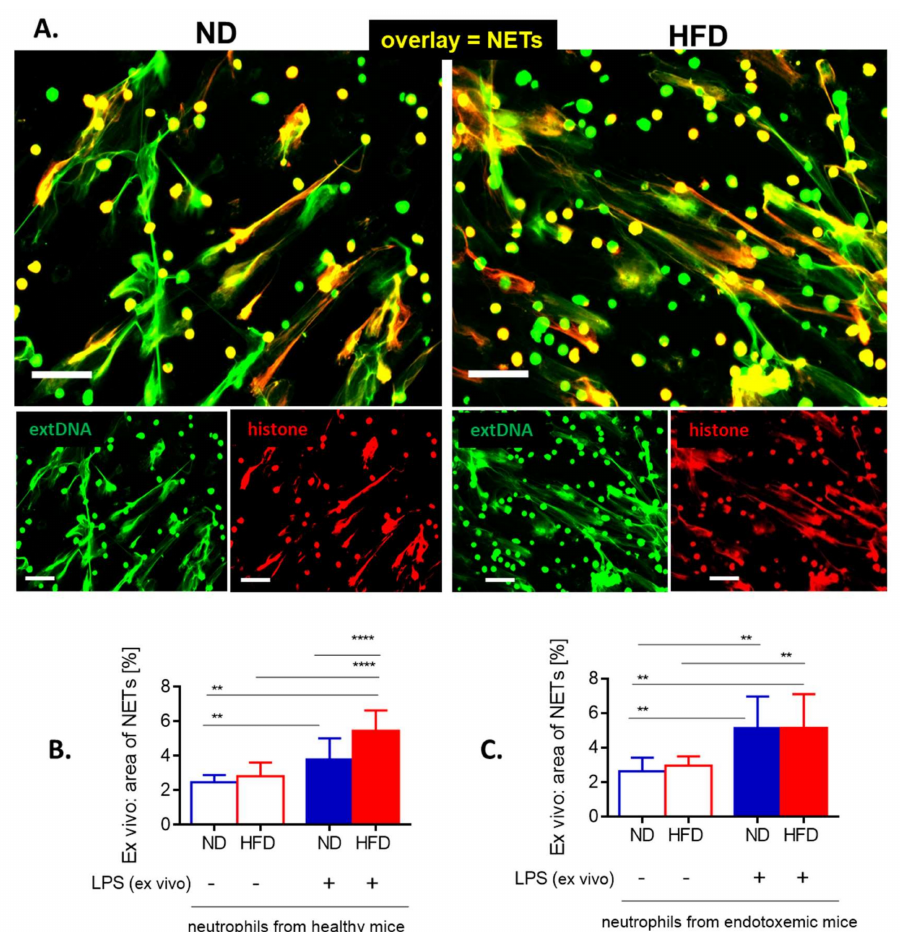
Figure 5. Release of neutrophil extracellular traps (NETs) by isolated bone marrow neutrophils of lean (ND) and obese (HFD) mice. ( A ) Representative images: NETs were visualized by costaining of citrullinated histone H3 (citH3, red) and extracellular DNA (extDNA, green) and their formation was evaluated 6 h after stimulation with lipopolysaccharide (LPS). The scale bar indicates 50 µ m. ( B, C ) NET quantification: area (%) covered by extDNA. Neutrophils were collected either from healthy mice (B) or mice with LPS-induced endotoxemia (C ). Asterisks indicate significant differences using unpaired two-tailed Student’s t -test (** p ≤ 0.01, **** p ≤ 0.0001). Data are shown as mean ± s.d.; n ≥ 3 per